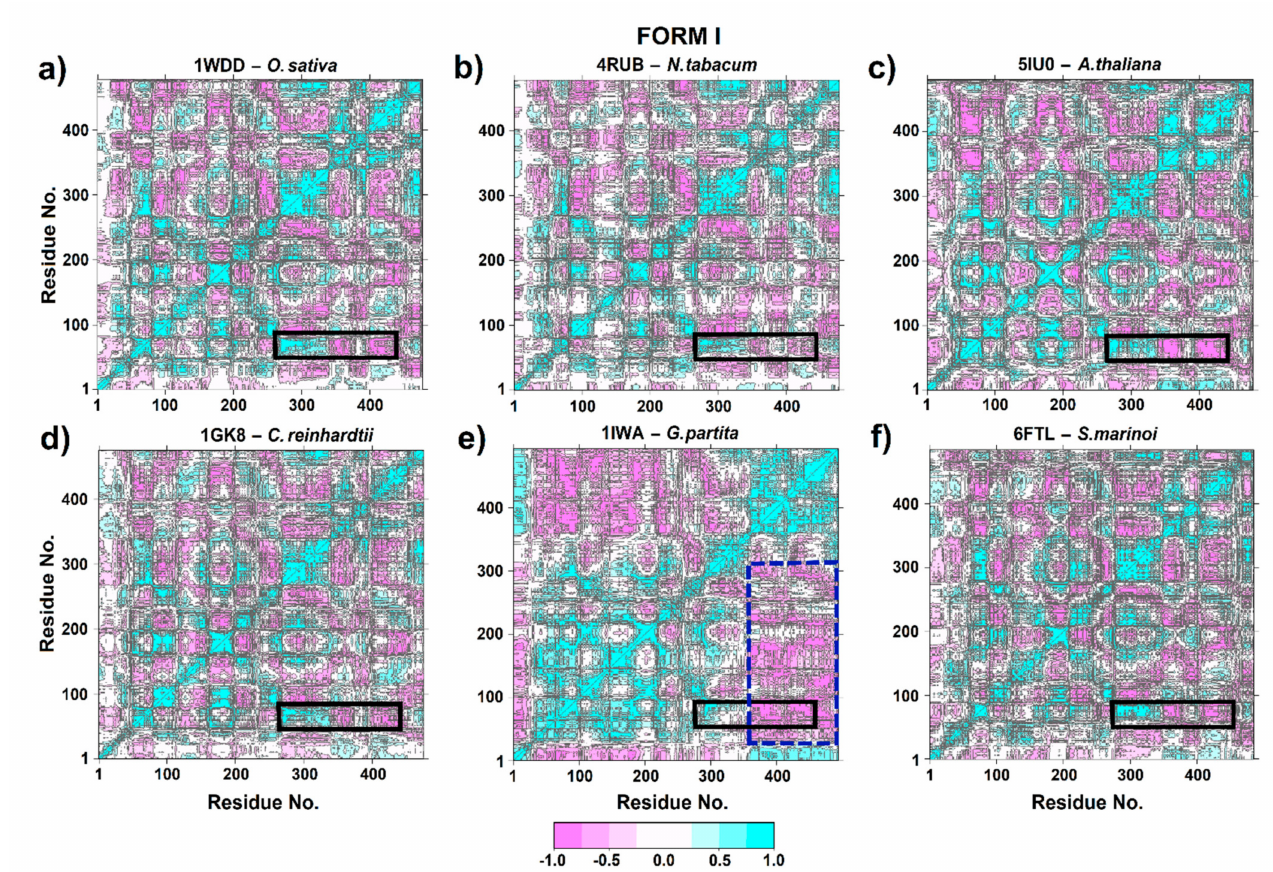
Figure 8. Cross-correlation analysis (DCCM) of RuBisCO form I. ( a ) O. sativa (1WDD); ( b ) N. tabacum (4RUB); ( c ) A. thaliana (5IU0); ( d ) G. partita (1IWA); ( e ) C. reinhardtii (1GK8) and ( f ) S. marinoi (6FTL). The color scale ranges from pink (for values ranging from − 1 to − 0.5) to white ( − 0.5 to 0.5) and to cyan (0.5 to